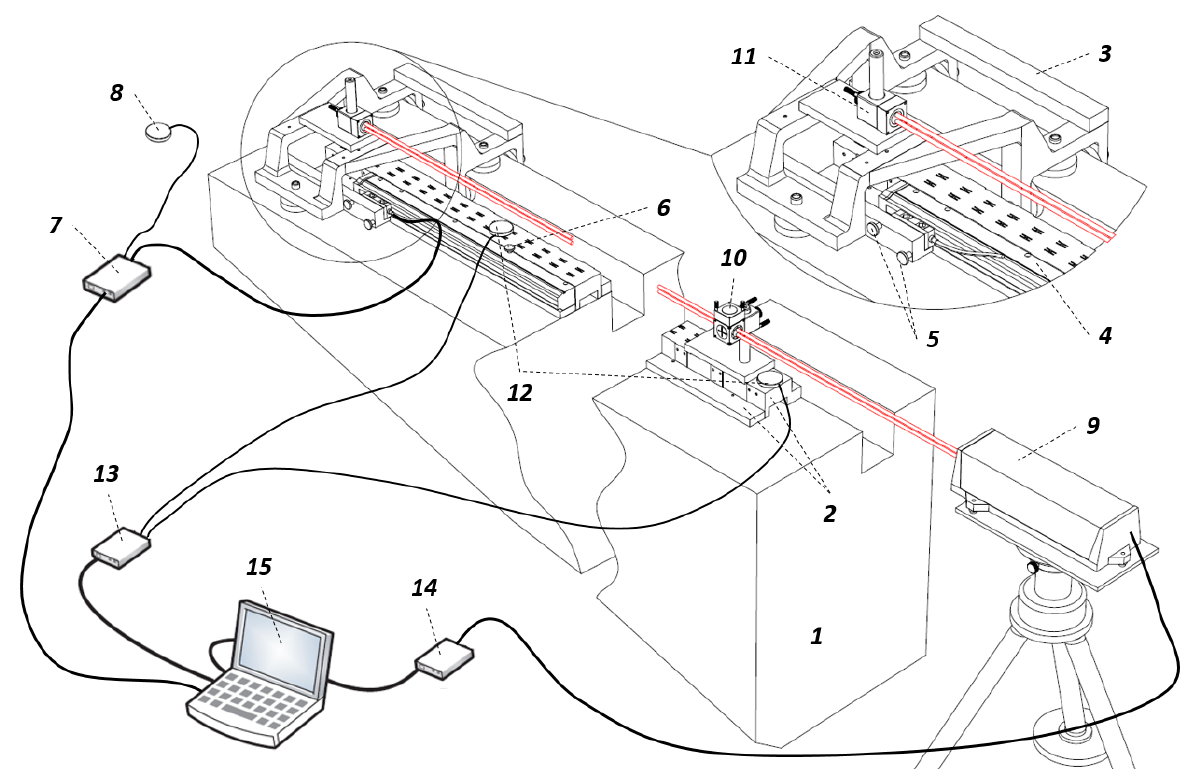
Figure 2. Experimental setup based on “Keysight 5530” system configured for a linear measurement.